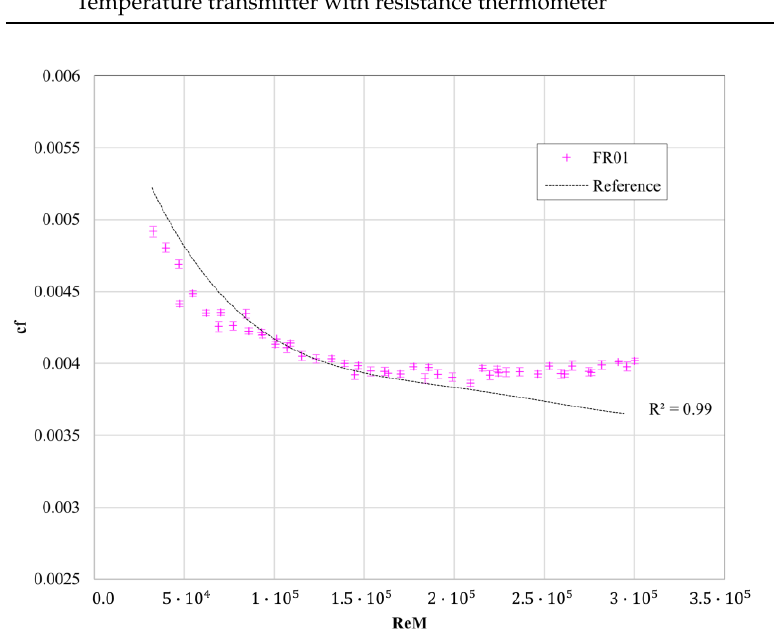
Figure 6. Skin-friction coefficient, c f , vs. Reynolds number, Re M for the FR01 soft foul-release coating. The error bars represent the overall uncertainty at 95% confidence level.